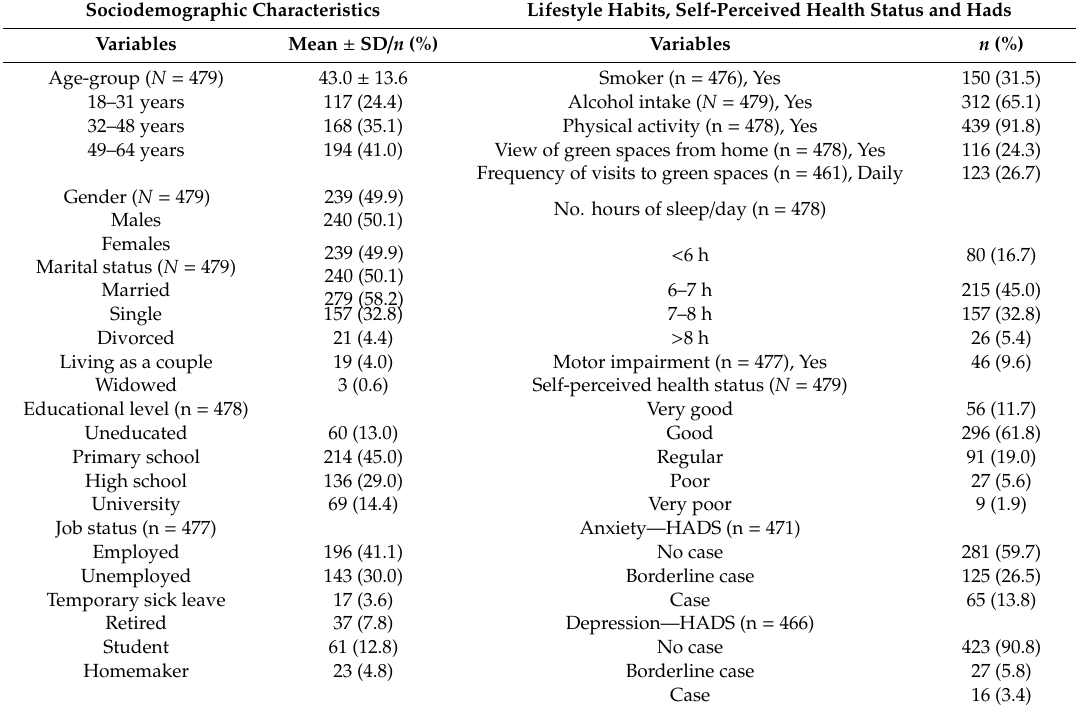
Table 1. Sample of sociodemographic, lifestyle habits, self-perceived health status and Hospital and Anxiety Depression Scale (HADS) in Carmona, Spain.